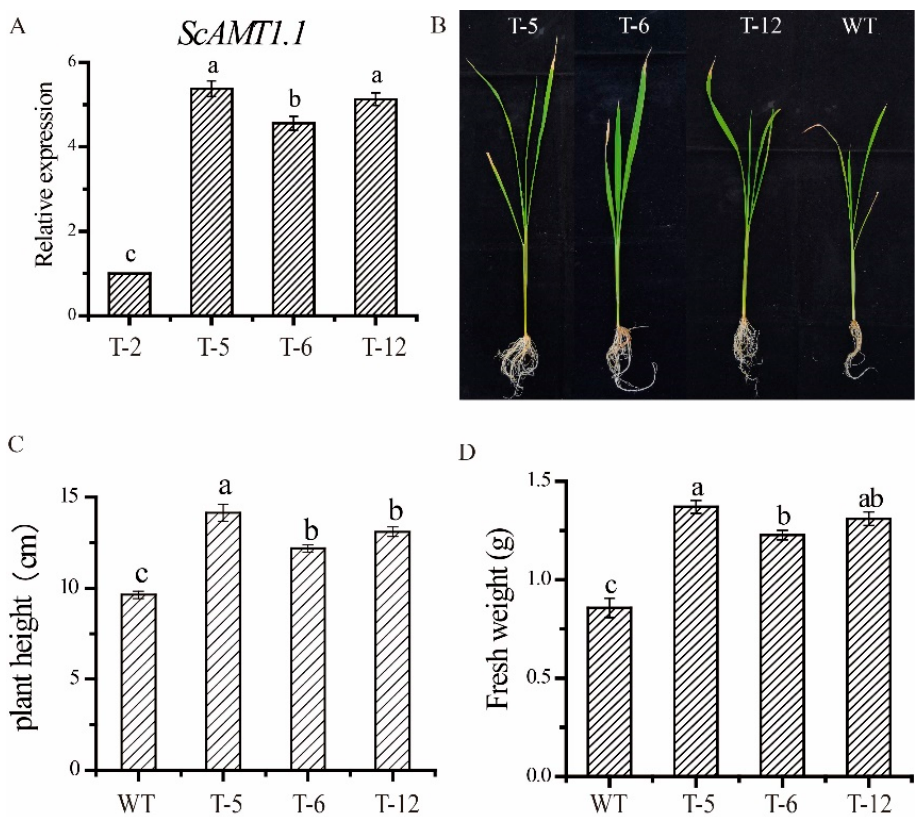
Figure 6. The transcription levels of ScAMT1.1 and the morphological parameters of the transgenic rice seedlings under low N stress. Notes: ( A ), Transcription level detection of the ScAMT1.1 gene in its transgenic rice plants. ( B – D ) represent the phenotype, plant height, and fresh weight of the transgenic and wild-type rice seedlings under low N stress, respectively. T-2, T-5, T-6, and T-12 represent the different transgenic lines. WT, wild-type. Data were mean ± standard error of three biological replicates. Bars with different letters were significantly different at the p < 0.05 level. 2.5. The Four Ammonium Assimilation Related Enzymes Were More Active in the Transgenic Lines Than That in the Wild-Type Plants Co-expression analysis results showed that the expression levels of all the ammo- nium assimilation-related genes, except for the NADH-dependent glutamate synthase gene ( NADH - GOGAT1 ), were significantly upregulated in the transgenic lines under low N condition (Figure 7A). Similar results were obtained from the experiments on enzyme activities (Figure 7B). No significant differences were found in the activity of the gluta- mate synthase (GOGAT) enzyme between the transgenic lines and the wild-type plants (Figure 7B). However, the activity of the other enzymes (glutamine synthetase, GS, and glutamate dehydrogenase, GDH) in the transgenic lines was significantly higher than those in the wild-type (Figure